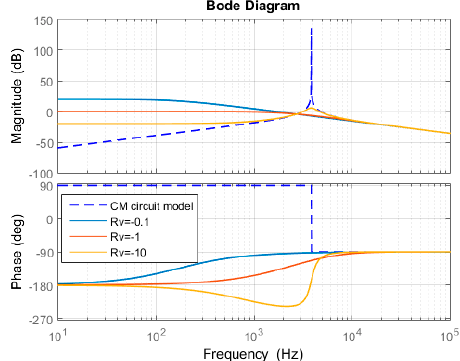
Figure 9. Bode diagram CM power stage: without R v and with R v connected in parallel with C f.